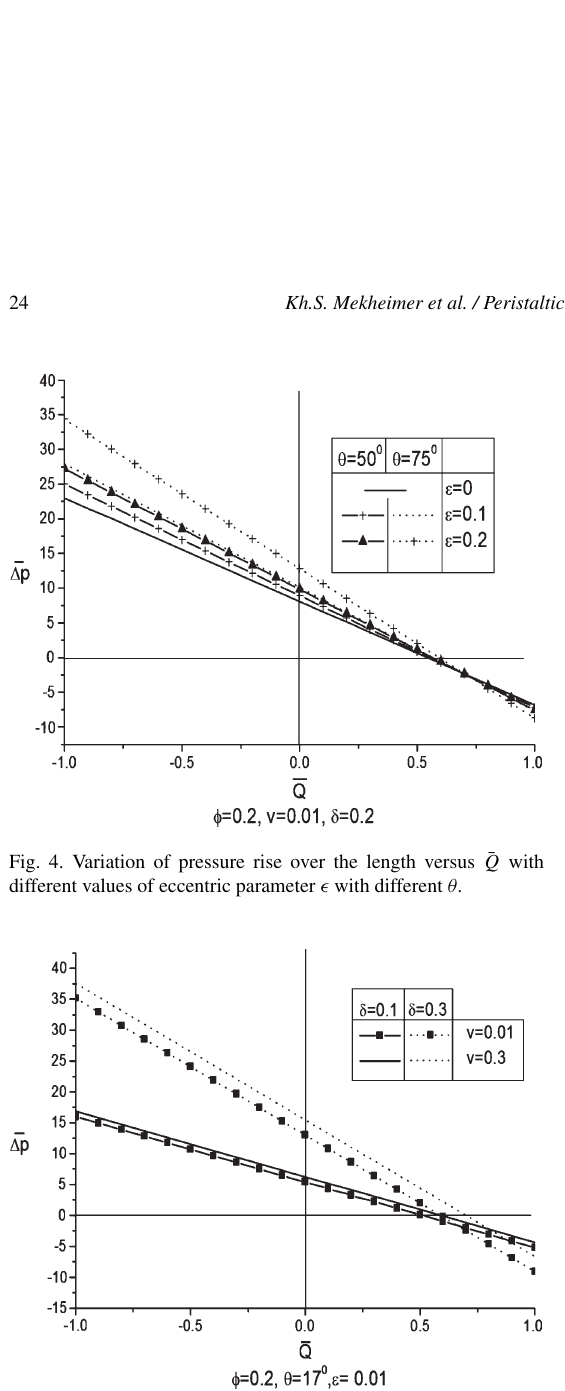
Fig. 7. Variation of the average inner Friction force over length ver- sus ¯ Q with different values of eccentric parameter (cid:2) at different θ